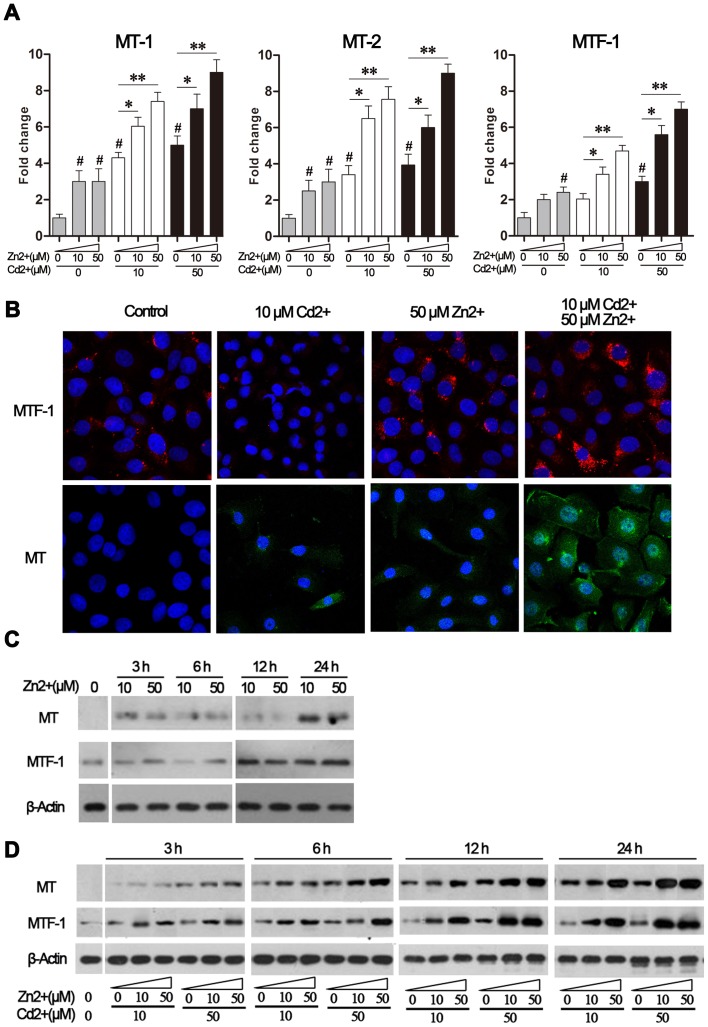
Zn2+ and Cd2+ increased expression of MTs and MTF-1.MDBK cells were treated with either Cd2+ alone (0, 10, 50 μM), or in combination with Zn2+ (0, 10, 50 μM), for up to 24 h. (A) MT-1, MT-2, and MTF-1 mRNA levels were determined by real-time PCR after 6-h treatments. Target gene threshold cycle (Ct) values were normalized to those of the reference gene (GAPDH) and the data were expressed as fold change over the medium-treated control sample, which was set as 1. The results are presented as the mean ± SD (n = 4). #P<0.05 compared to the medium-treated control group; *P<0.05, and **P<0.01 compared to the cells exposed to Cd2+ alone (10 or 50 μM). (B) Protein levels of MTs and MTF-1 after 6-h treatments were evaluated by fluorescence microscopy at ×400 magnification following staining with anti-MTF-1 or anti-MT antibodies. (C) Protein levels of MTs and MTF-1 in response to Zn2+ treatment (10 or 50 μM) at the indicated time points, as determined by western blot analysis. (D) Protein levels of MTs and MTF-1 in response to exposure to both Zn2+ and Cd2+ (10 and 50 μM, respectively) at the indicated time points, as determined by western blot analysis. In (C) and (D), expression of β-actin was used as the loading control.